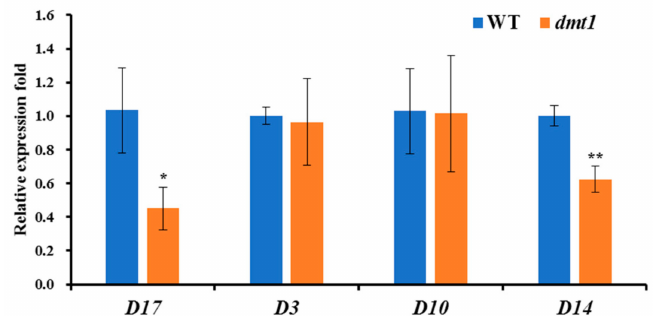
Figure 4. The expression patterns of DWARF3 (D3) , D10 , D14 , and D17 between the dmt1 mutant and the WT. ACTIN1 was used for a control. * p < 0.05, ** p < 0.01, Student’s t